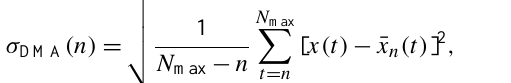
Fig. 8. The dependence of the kurtosis κ of the magnetic field increments ( δ H ( τ ) ) on the timescales τ for the two selected periods.